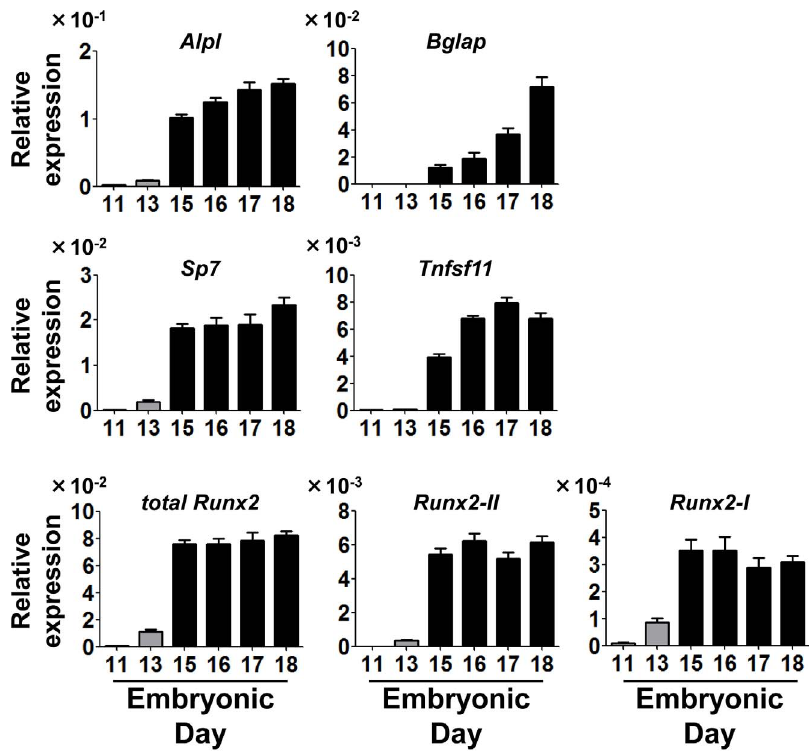
Figure 6. Osteoblastic gene expression profile during fetal development. Pregnant C57BL/6 mice were euthanized for examination of fetuses on days 11, 13, 15, 16, 17, and 18 postcoitum. The calvaria of fetuses were enzymatically digested, and collected cells were subjected to the quantitative real-time PCR analyses. Because the fetuses at days 11 and 13 did not yet have firm calvarial structures, we instead used the upper part of head tissue, which might have contained cells other than calvarial cells (e.g., brain and skin cells). Data are means 6 SEM ( n =7–9/group).